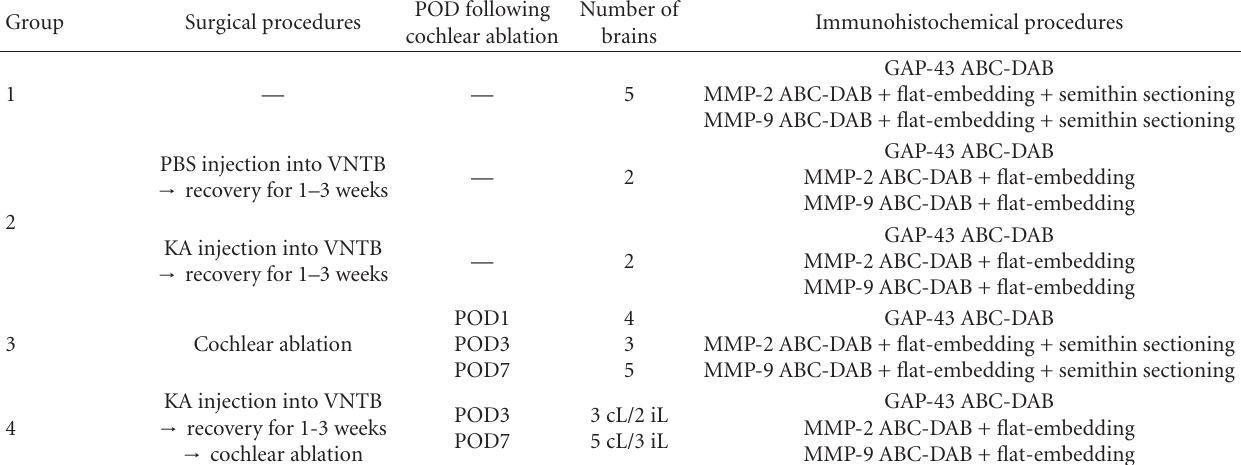
Table 1: Experimental